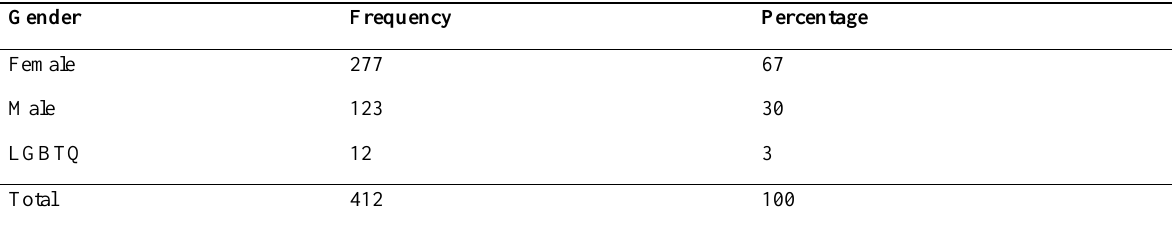
Table 1: Gender of participants